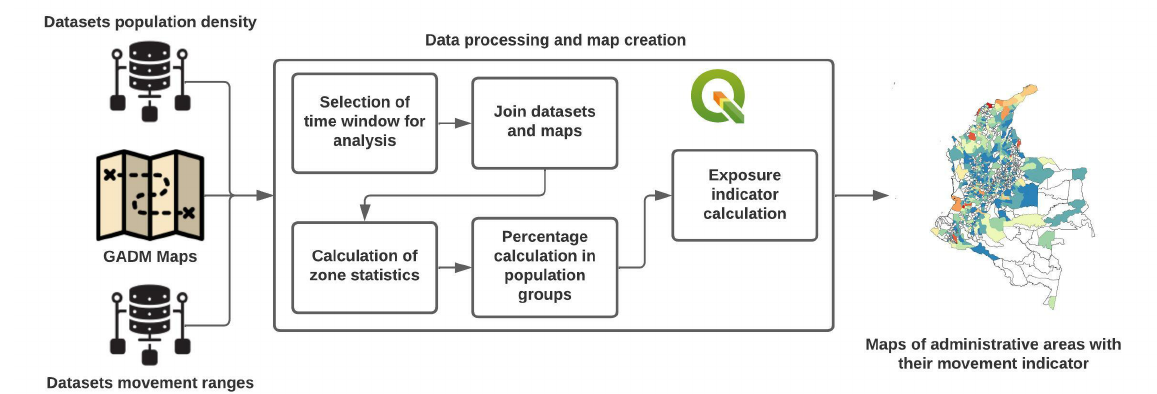
Figure 1. Process for constructing and determining the exposure indicator for each administrative area in the movement range